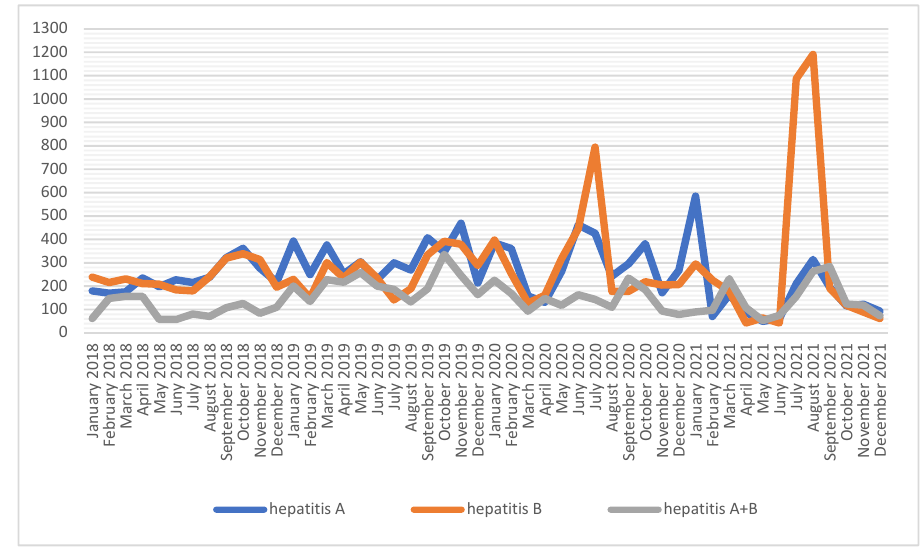
Figure 5. Number of vaccinations against hepatitis A and B among soldiers in 2018–2021. There were three increases in the vaccinations against cholera, which reached their